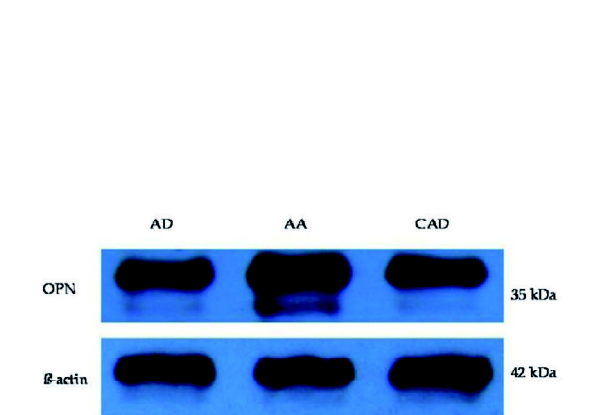
Fig. 2 - Quantitative real-time RT-PCR of osteopontin mRNA. P= 0.318 for AD vs. AA, P= 0.393 for AD vs. CAD, and P = 0.947 for AA vs. CAD. AA: aortic aneurysm; AD: aortic dissection; CAD: coronary artery disease